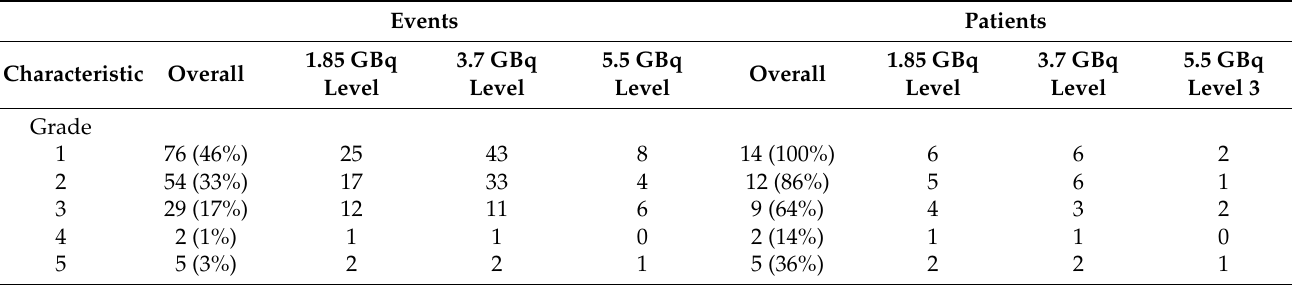
Table 2. Summary of all adverse events in the analysis population.